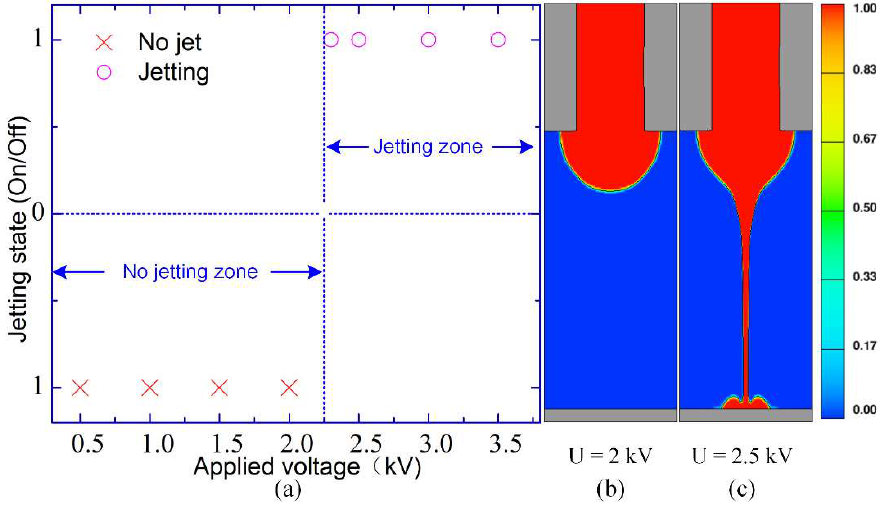
Figure 8. ( a ) Relationship between jetting state and applied voltage, ( b , c ) Images of meniscus shape at the same calculating moment ( t = 0.4 ms) in 2.0 kV and 2.5 kV, respectively.